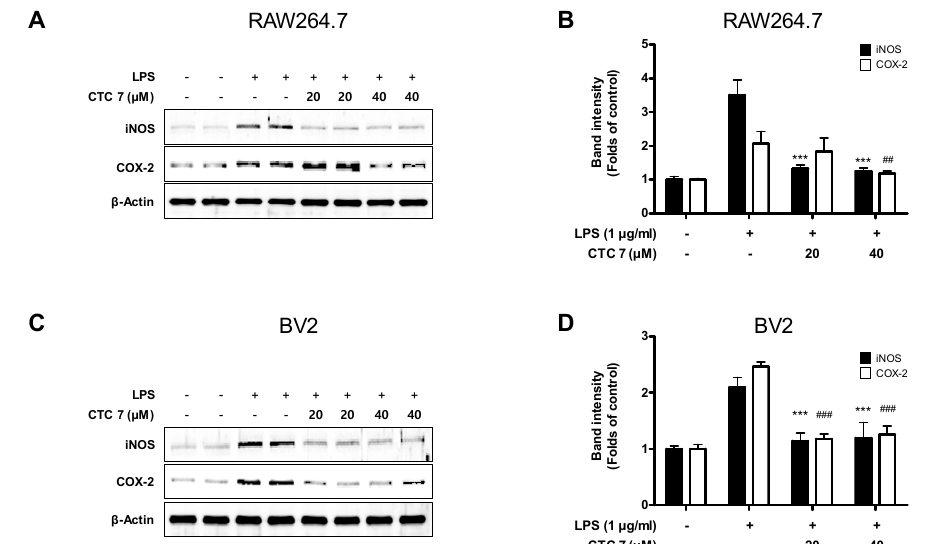
Figure 8. Effects of CTC 7 treatment on the protein expression levels of iNOS ( A ) and COX-2 ( B ) in LPS-stimulated RAW264.7 and BV2 cells. Cells were pretreated for 3 h with the indicated concentrations of CTC 7 and stimulated for 24 h with LPS (1 μ g/mL). Western blot analysis was performed as described in the Materials and Methods. Immunoblotting was performed using ImageJ software. Band intensities were normalized to that of β -actin. *** p < 0.001, ## p < 0.01, ### p < 0.001 when compared with the LPS-treated control.